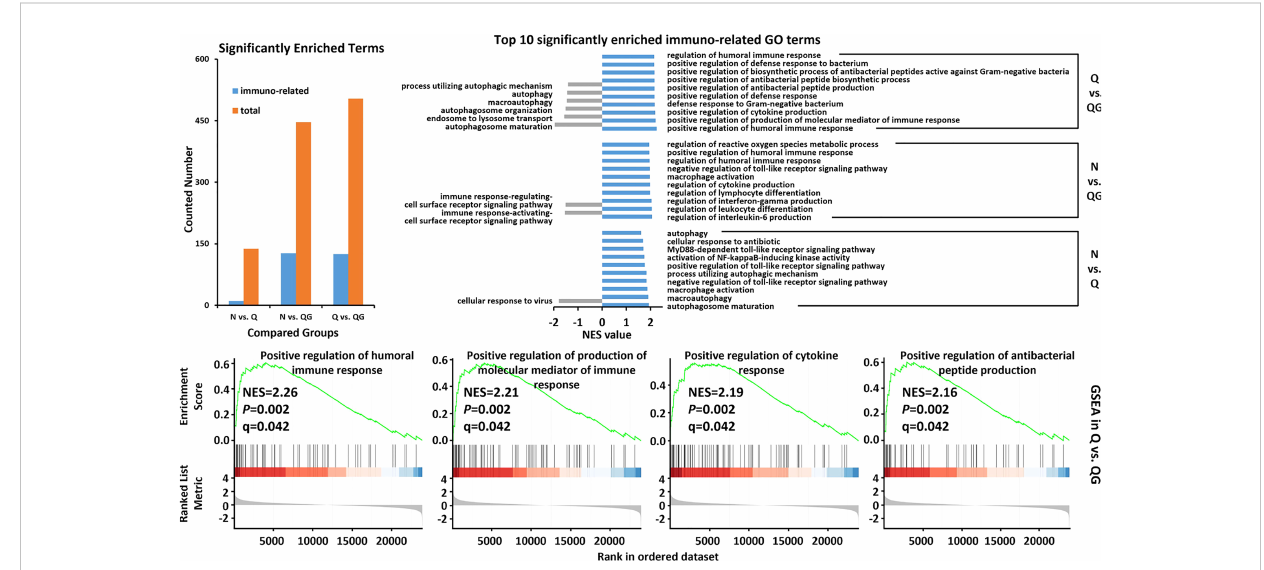
FIGURE 5 The critical GO pathways associated with immune response to hypoxia and sul fi de in haemolymph of Tegillarca granosa were explored by gene set enrichment